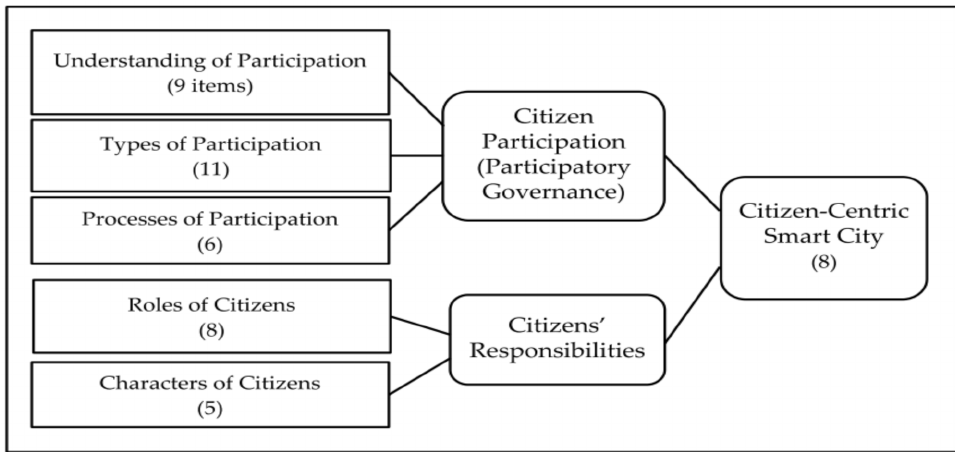
Figure 4. Dimensions in building a citizen-centric city, derived from